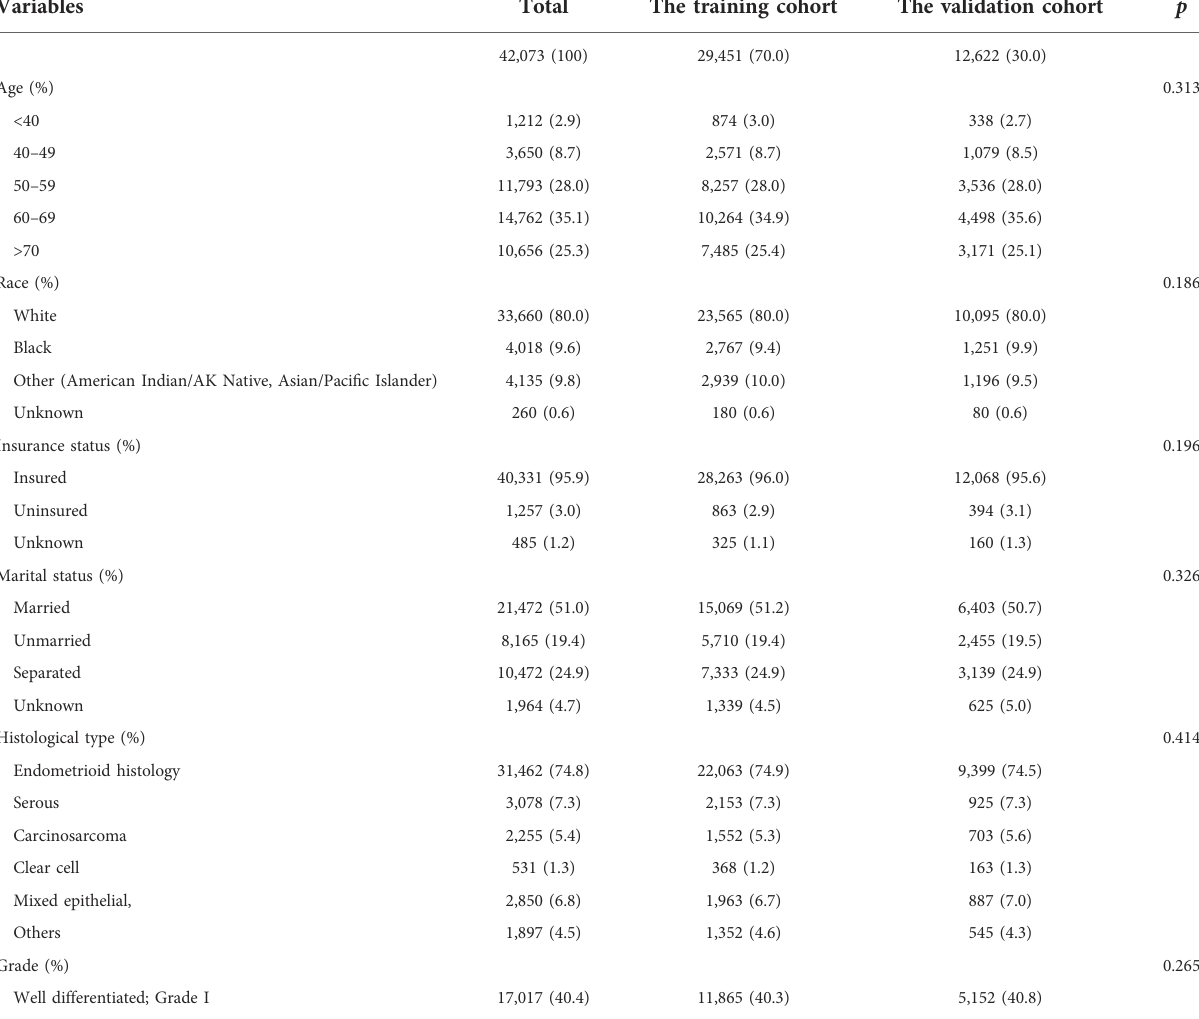
TABLE 2 Demographical and clinical characteristics between patient with the primary cohort and the validation cohort.